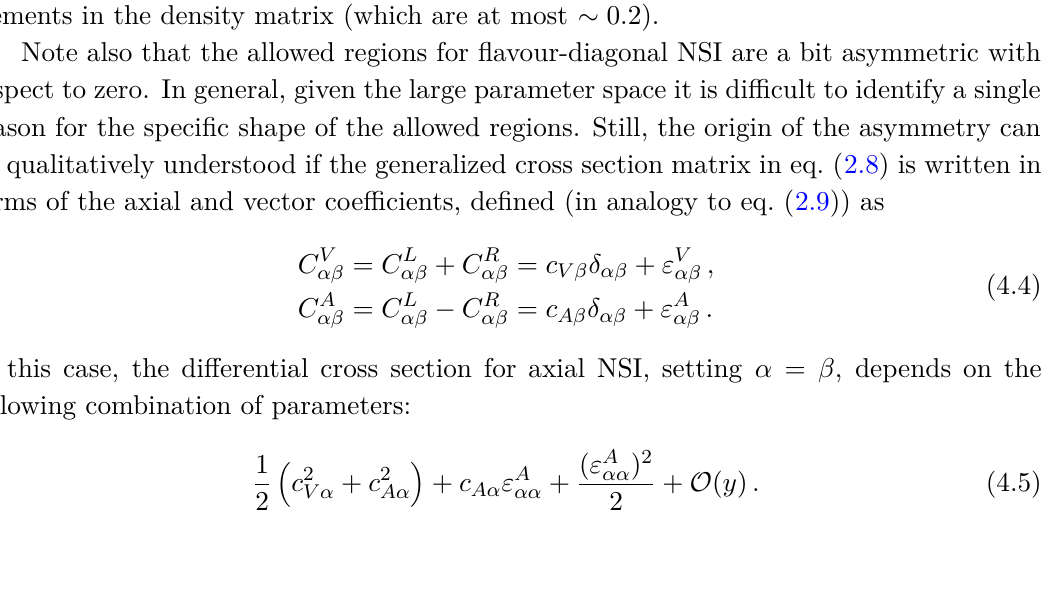
Figure 3 . Results for axial NSI with electrons ( ε L dimensional allowed confidence regions at 1 σ and 2 σ (for 2 d.o.f., using two-sided intervals ∆ χ 2 = 2 . 30 , 6 . 18 ), while the remaining panels show the profile of the ∆ χ 2 for each of the parameters indi- vidually. In each panel, the results are obtained after minimization over the parameters not